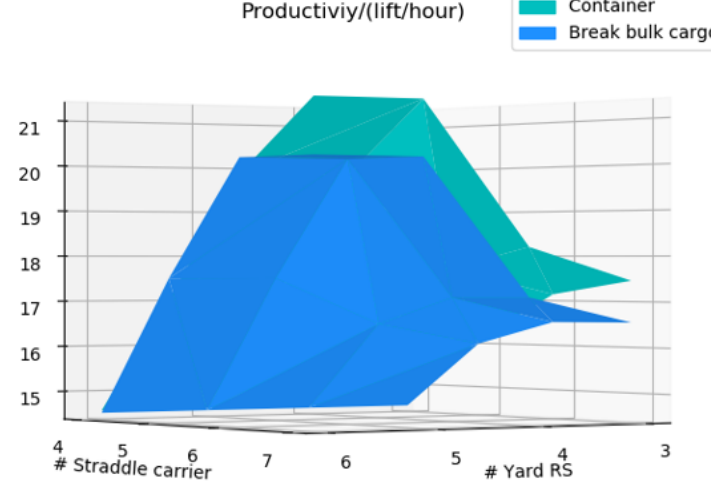
Figure 14. Productivities when using straddle